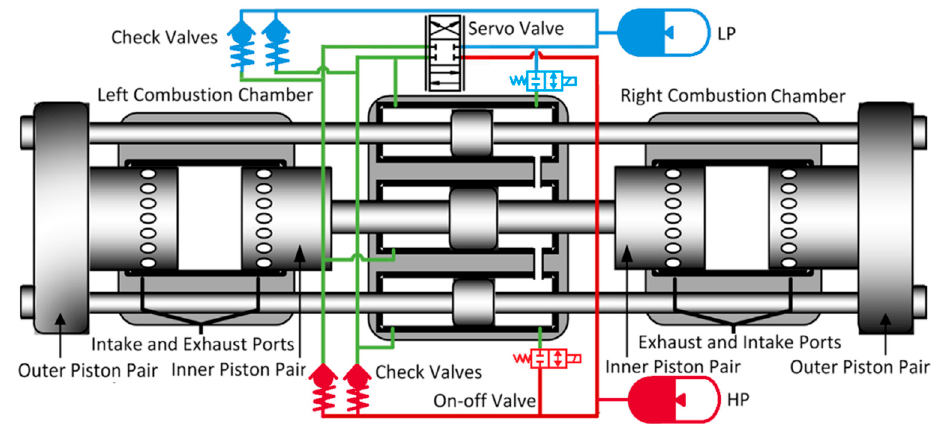
Figure 13. One kind of complex-configuration HFPE [31].